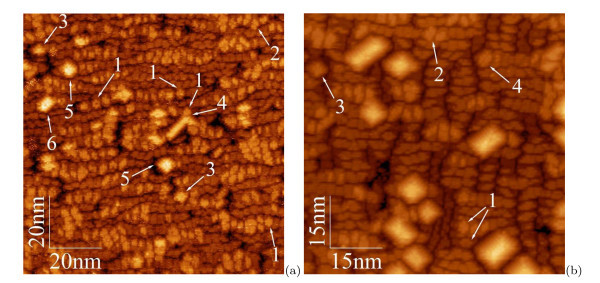
STM images of Ge WL on Si(001): (a) hGe = 5.4 Å (Us = +1.80 V, It = 100 pA) and (b) hGe = 6.0 Å (Us = +2.50 V, It = 80 pA). Examples of characteristic features are numbered as follows: nuclei of pyramids (1) and wedges (2) [1 ML high over WL], small pyramids (3) and wedges (2) [2 ML high over WL, a Γ-like wedge [18] is observed in the image (a)], 3 ML high pyramids (5) and wedges (6).